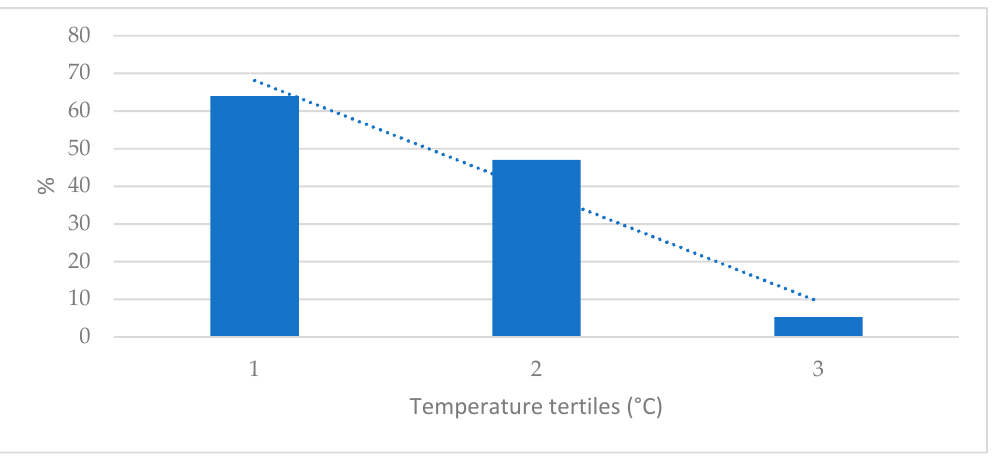
Figure 4. Proportions of positive samples for each tertile of temperature (1st tertile ≤ 32.0 °C; 2nd tertile = 32.1–47.2 °C; 3rd tertile ≥ 47.3 °C). The dashed blue line shows the decreasing trend of positive samples.